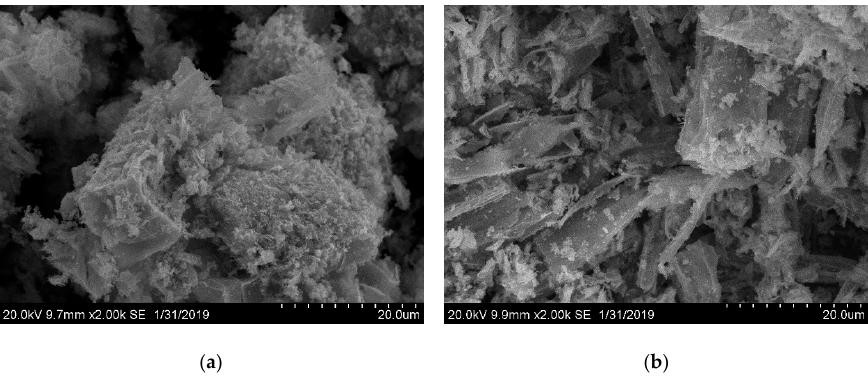
Figure 7. SEM images of MnO sample obtained by the oxidative thermolysis of 4 ( a ) and 5 ( b